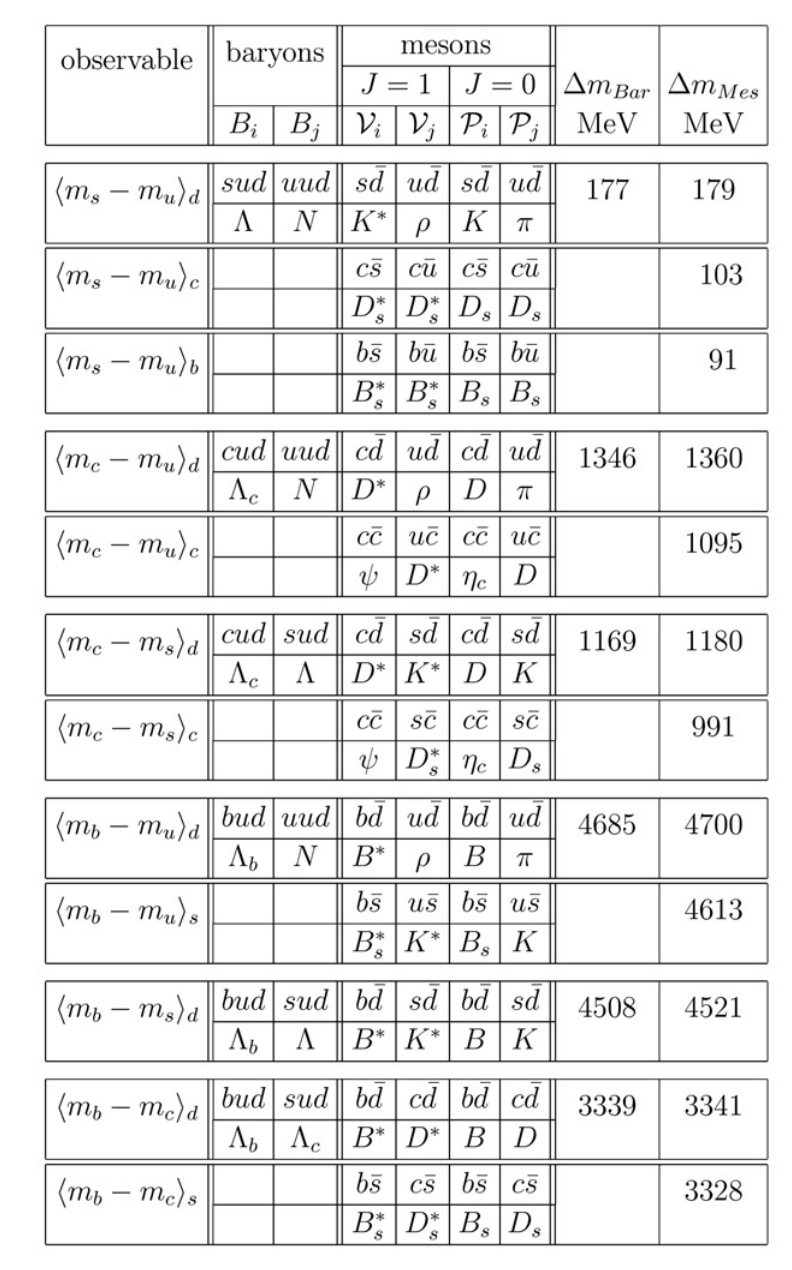
Table I. Di ff erences of e ff ective quark masses [1]. The mass di ff erence between two quarks of di ff erent flavors are seen to have the same value to a good approximation when they are bound to a nonstrange antiquark to make a meson and bound to a nonstrange diquark to make a